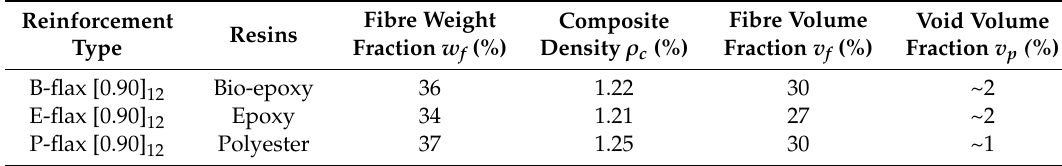
Table 2. Physical properties of flax fiber tape